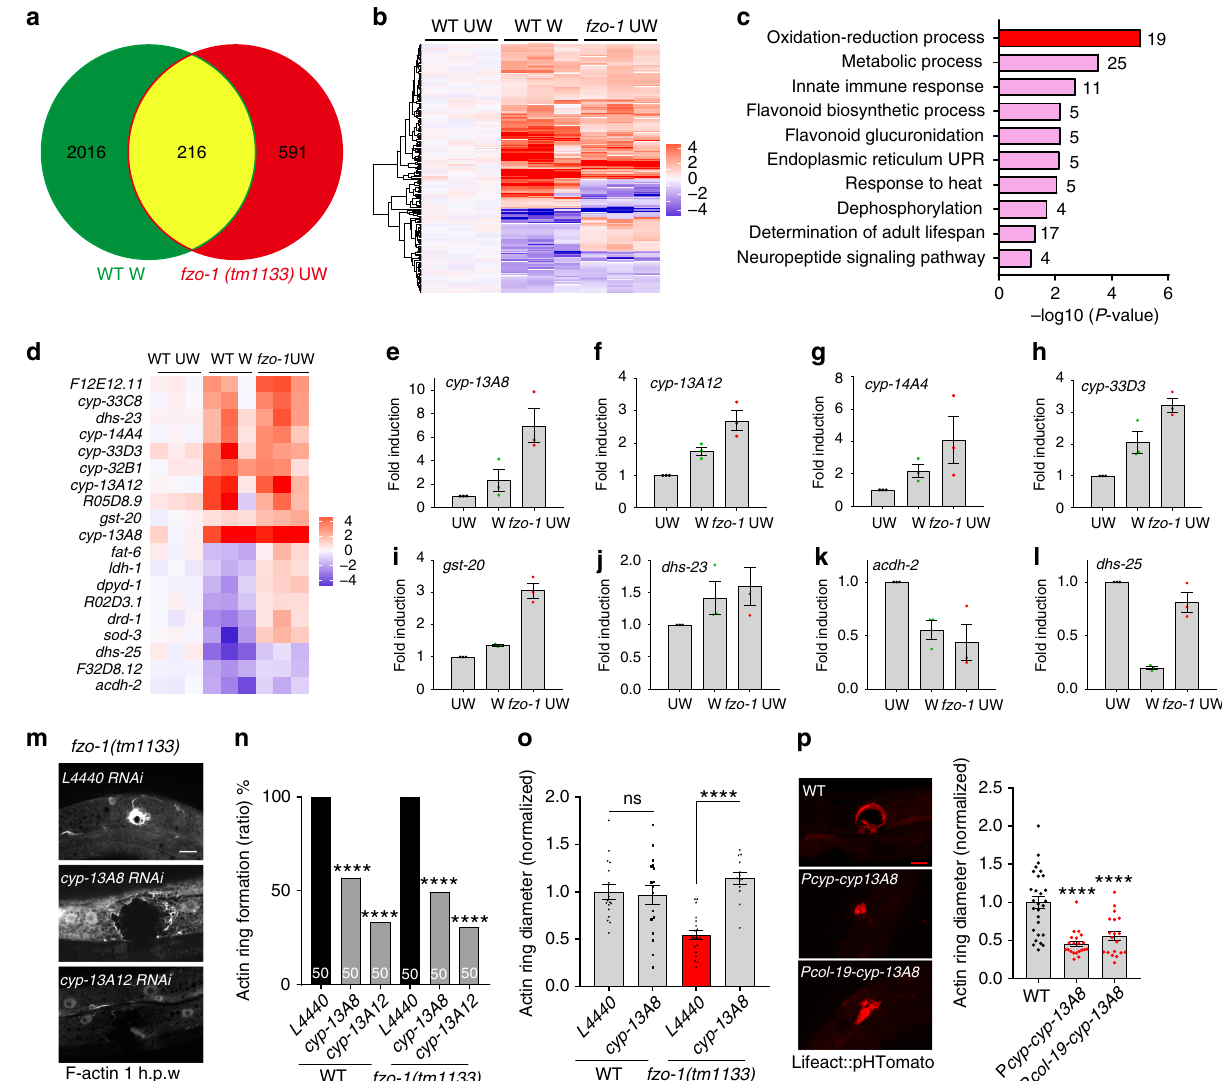
Fig. 6 The upregulation of oxidative signals in fzo-1 mutants is required for faster wound closure. a Venn diagram of differentially expressed genes (DEGs) in WT needle wounded and fzo-1(tm1133) unwounded animals, compared to WT unwounded controls, as measured by RNA-seq (Benjamini- Hochberg adjusted P value <0.001). See also Supplementary Data 1. b Gene expression heatmap of 216 DEGs shared by WT wounded and fzo-1 unwounded animals as described in a . c DAVID biological process GO terms of upregulated and downregulated genes in the 125/216 overlapping DEGs (Benjamini-Hochberg adjusted P value <0.001). See also Supplementary Data 2. d Heatmap of 19 overlapping oxidation-reduction processes genes. e – l Quanti fi cation of oxidation-reduction process-related genes in the WT, wounded, and fzo-1 animals as determined by qPCR. In both WT wounded and fzo-1 mutant, cyp-13A8 , cyp-13A12 , cyp-14A4 , cyp-33D3 , gst - 20 , dhs-23 , and dhs-28 were upregulated while acdh-2 , dhs-25 are down-regulated. N = 3 independent experiments; Bars indicate mean ± SEM. m Representative confocal images of actin ring formation 1 h.p.w. RNAi knockdown of cyp-13A8 and cyp-13A12 suppresses the accelerated actin ring formation in fzo-1(tm1133) . Scale bar, 10 μ m. N = 3 independent experiments. n Quantitation of acti n ring formation percentage in the WT and fzo-1(tm1133) double mutants with RNAi knockdown cyp-13A8 , and cyp-13A12 genes. N = 50, **** P < 0.0001, versus WT or fzo-1(tm1133) , Two-sided Fisher ’ s exact test. o Quantitation of actin ring diameter in the WT and fzo-1(tm1133) double mutants with RNAi knock down cyp-13A8 (WT-L4440, n = 17; WT- cyp-13A8 , n = 17; fzo-1 -L4440, n = 19; fzo-1;cyp-13A8 , n = 13 animals). Bars indicate mean ± SEM, ns, P = 0.803, **** P < 0.0001, versus WT or fzo-1(tm1133) . two-tailed unpaired t -test. p Overexpression of CYP-13A8 in epidermis accelerates wound closure. Left, representative actin ring images, Scale bar, 10 μ m. Right, quantitation of actin ring diameter 1 h.p.w (WT, n = 28; Pcyp-13A8-cyp-13A8 , n = 21; Pcol-19-cyp- 13A8 , n = 19 animals). Bars indicate mean ± SEM, **** P < 0.0001, versus non transgenic animals. One-way ANOVA Dunnett ’ s test. Source data are provided as a Source Data fi displayed signi fi cantly increased mitoSox fl uorescence (Fig. 7a) CYPs can generate reactive oxygen species (ROS) 44,45 , and and mito::cpYFP intensity (Supplementary Fig. 7a), whereas drp-1 CYP expression is subject to feedback regulation by mtROS 46 . Therefore, we examined mitochondrial ROS (mtROS) production (tm1108) mutants showed reduced mitoSox staining (Fig. 7a). in the fragmented mitochondrial mutants by staining with Treatment of animals with mitochondrial fragmentation inducers either the ROS sensor mitoSox or the genetically encoded sensor Rotenone or FCCP signi fi cantly enhanced the mitoSox signal mito::cpYFP 47 . Both fzo-1(tm1133) and eat-3(tm1107) mutants (Supplementary Fig. 7b) and also induced CYP expression